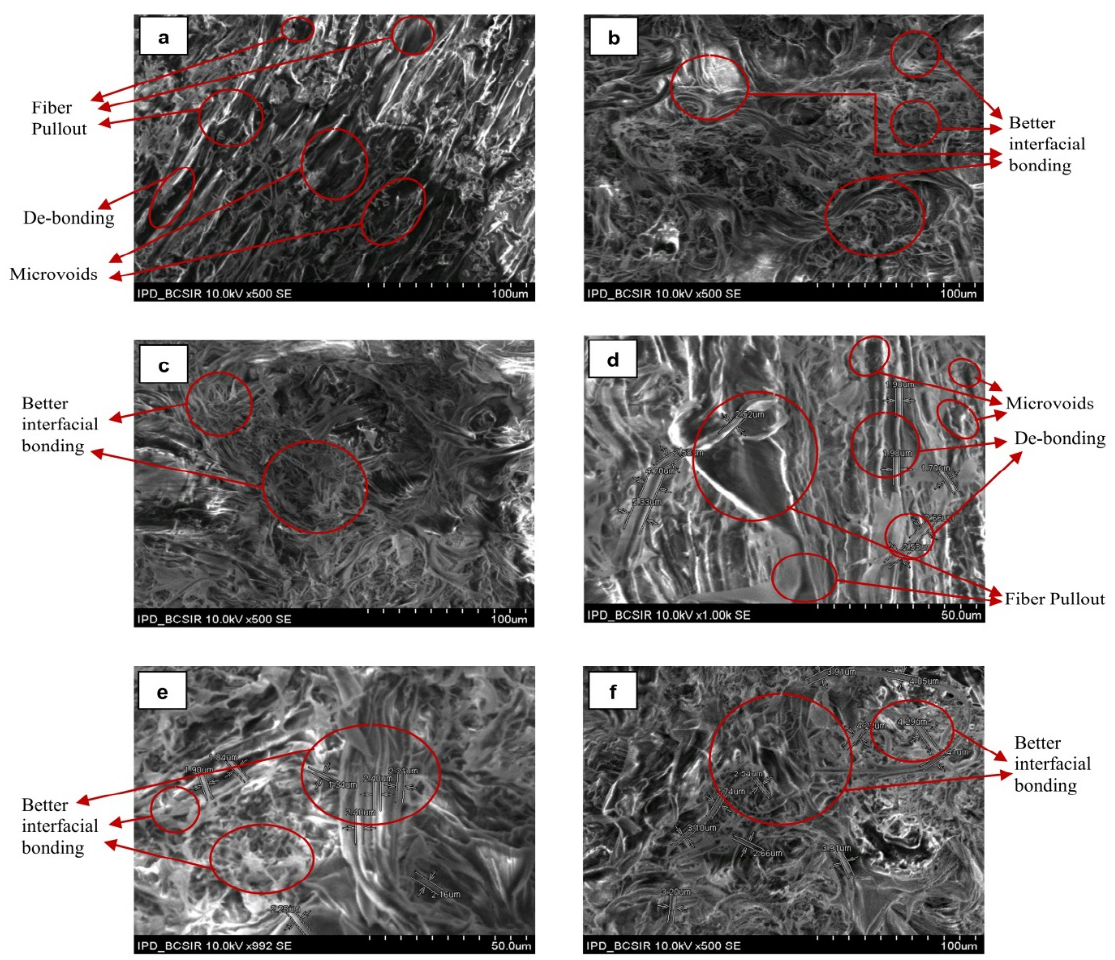
Figure 9: SEM micrographs of 35 wt% WH-PP composites: (a) tensile fracture surface of raw WH composite, b) tensile fracture surface of (NNDMA)/NaOH treated WH composite, c) tensile fracture surface of (Anl)/NaOH treated WH composite, (d) flexural fracture surface of raw WH composite, (e) flexural fracture surface of (NNDMA)/NaOH treated WH composite, and (f) flexural fracture surface of (Anl)/NaOH treated WH